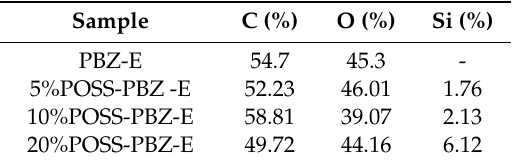
Table 2. EDX analysis results of the SPOSS-PBZ-E composites.